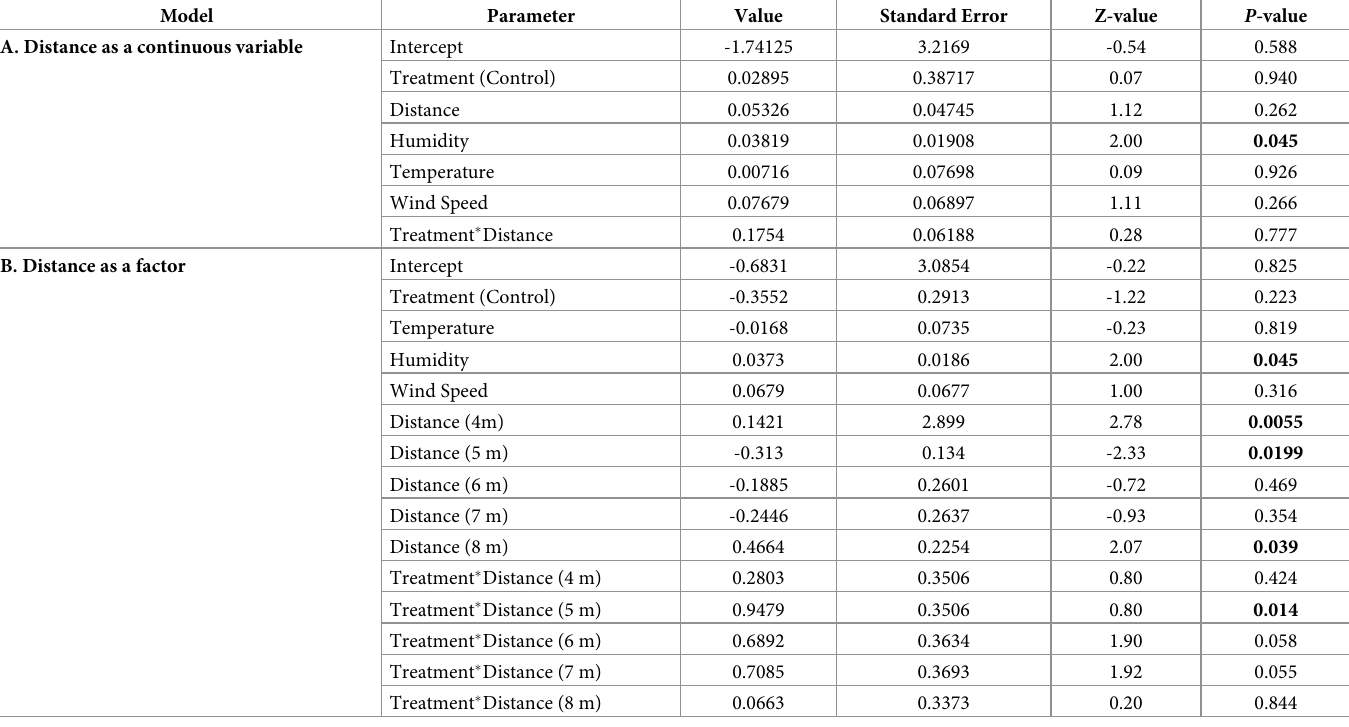
Table 2. IRR estimated from GLMM of landing counts upon exposure to emanators at different distances outdoors.